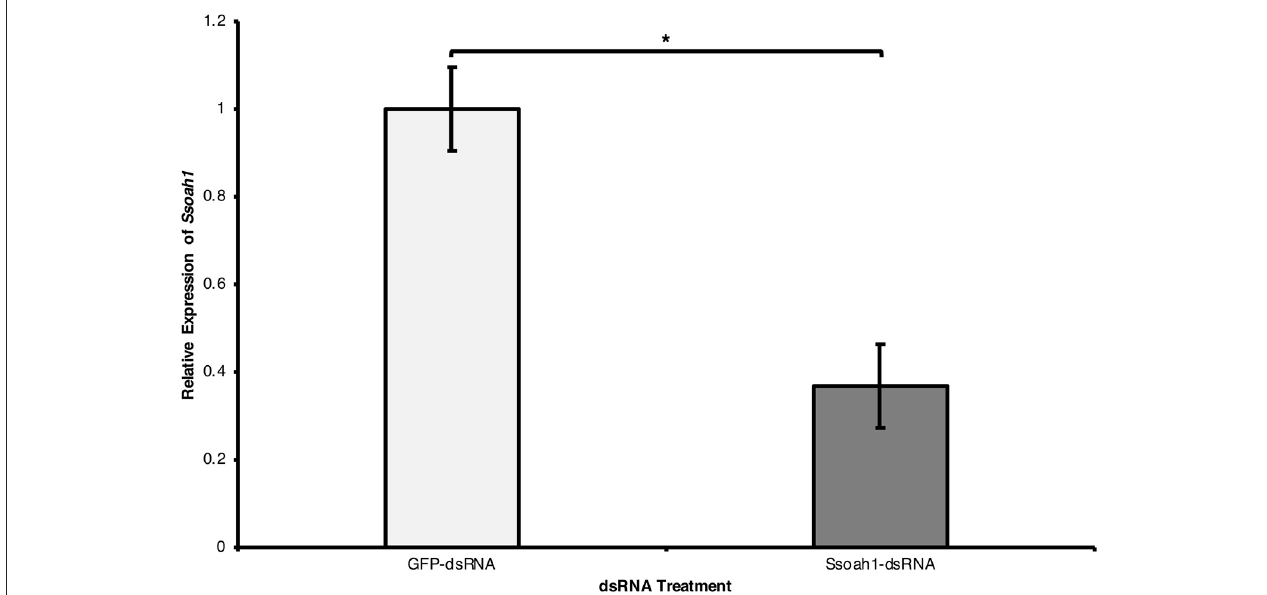
FIGURE 2 | External uptake of Ssoah1 -dsRNA decreased Ssoah1 transcript levels in Sclerotinia sclerotiorum . A concentration of 500ng/mL of Ssoah1 -dsRNA were applied to potato dextrose broth (pH 8) and a potato dextrose agar plug containing mycelia of S. sclerotiorum was placed in the broth. Treatment with a same concentration of GFP-dsRNA served as negative control. Mycelia were collected 96h after addition to PDB and the transcript level of Ssoah1 were analyzed. Relative expression of Ssoah1 was normalized to S. sclerotiorum H3 and relative to the GFP negative control. Ssoah1 transcript levels were significantly reduced across three experimental replicates (* p < 0.01). Error bars represent ± standard errors of three (for R1 and R2) or for (for R3) biological replicates across three experimental